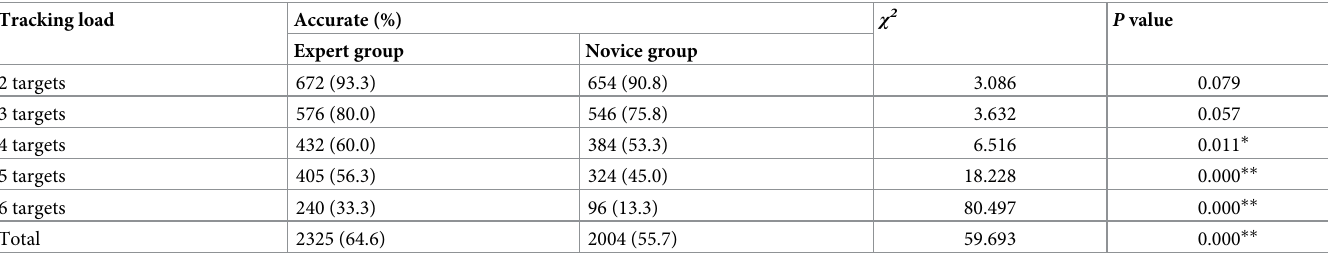
Table 1. Comparison of AVTNs between the expert group and novice group. Tracking